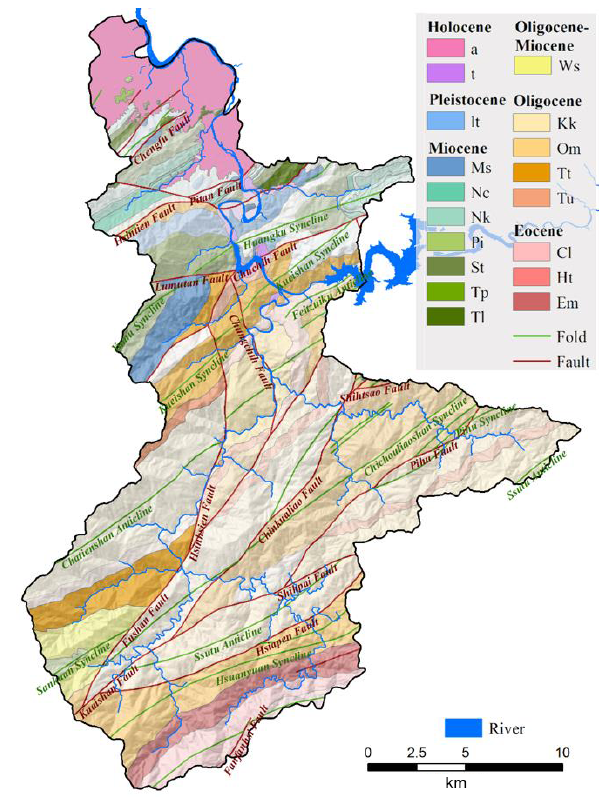
Figure 4. Lithological map – 1 : 50000 scale; the abbreviations in the legend are listed in Table